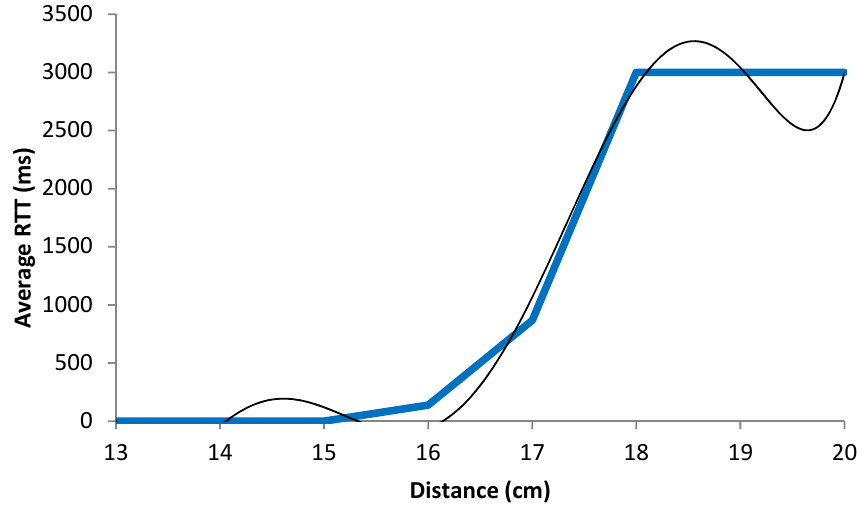
Figure 20. Average RTT for 5.5